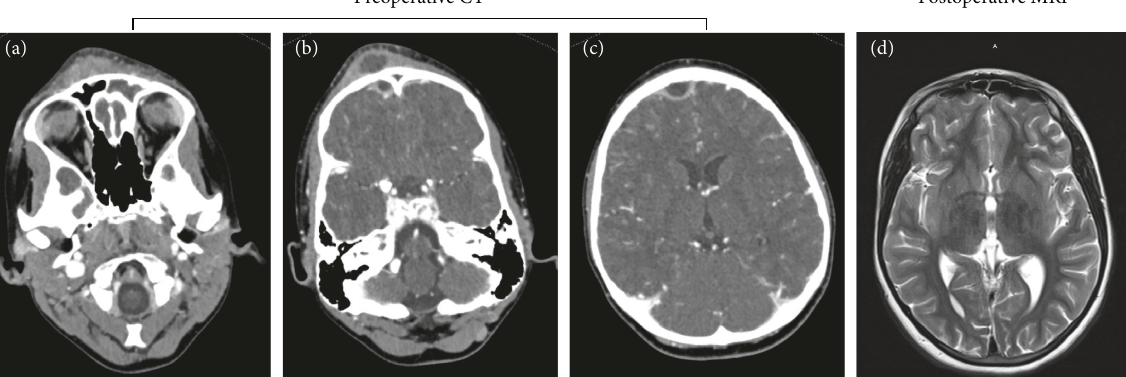
Figure 1: Imaging findings before and after balloon dilation. (a)–(c) Preoperative head CTslices with contrast of one case included in the study: (a) fluid-density opacification of the frontal sinus; (b) contrast-enhancing subperiosteal fluid collection overlying the frontal bone, consistent with Pott’s puffy tumor; (b)-(c) contrast-enhancing intracranial fluid collection consistent with epidural abscess. (d) T2 MRI six weeks after surgery revealing resolution of abscesses and aeration of the frontal